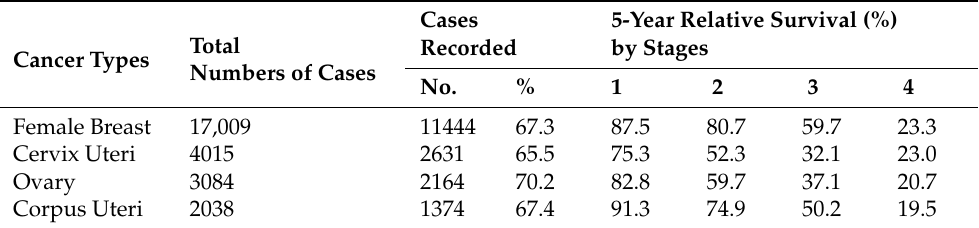
Figure 1. Female Breast; Relative survival by year and staging, period of diagnosis 2007–2011 and followed up to 2016, Malaysia [5,10]. Table 1. Relative survival by stage of diagnosis and cancer types, period of diagnosis 2007–2011 and followed up to 2016, Malaysia [5,10].